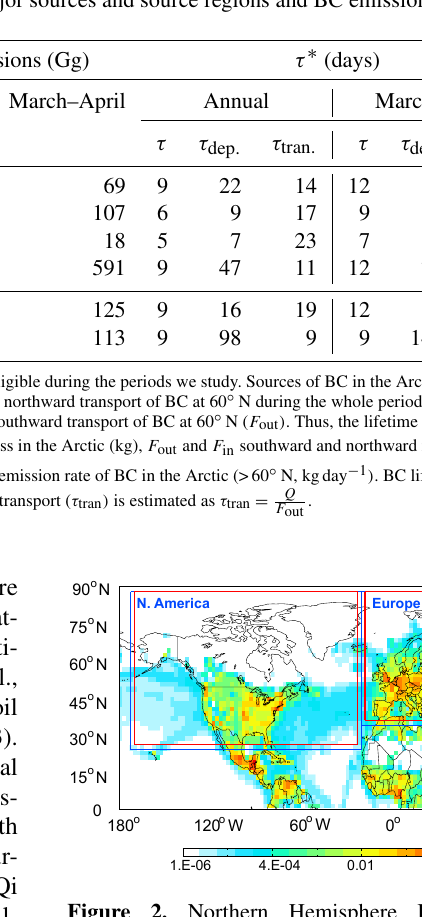
Figure 2. Northern Hemisphere BC emissions for April (Ggmonth − 1 ) . BC tracers are “tagged” by four anthropogenic (blue rectangles) and five biomass burning sources (red